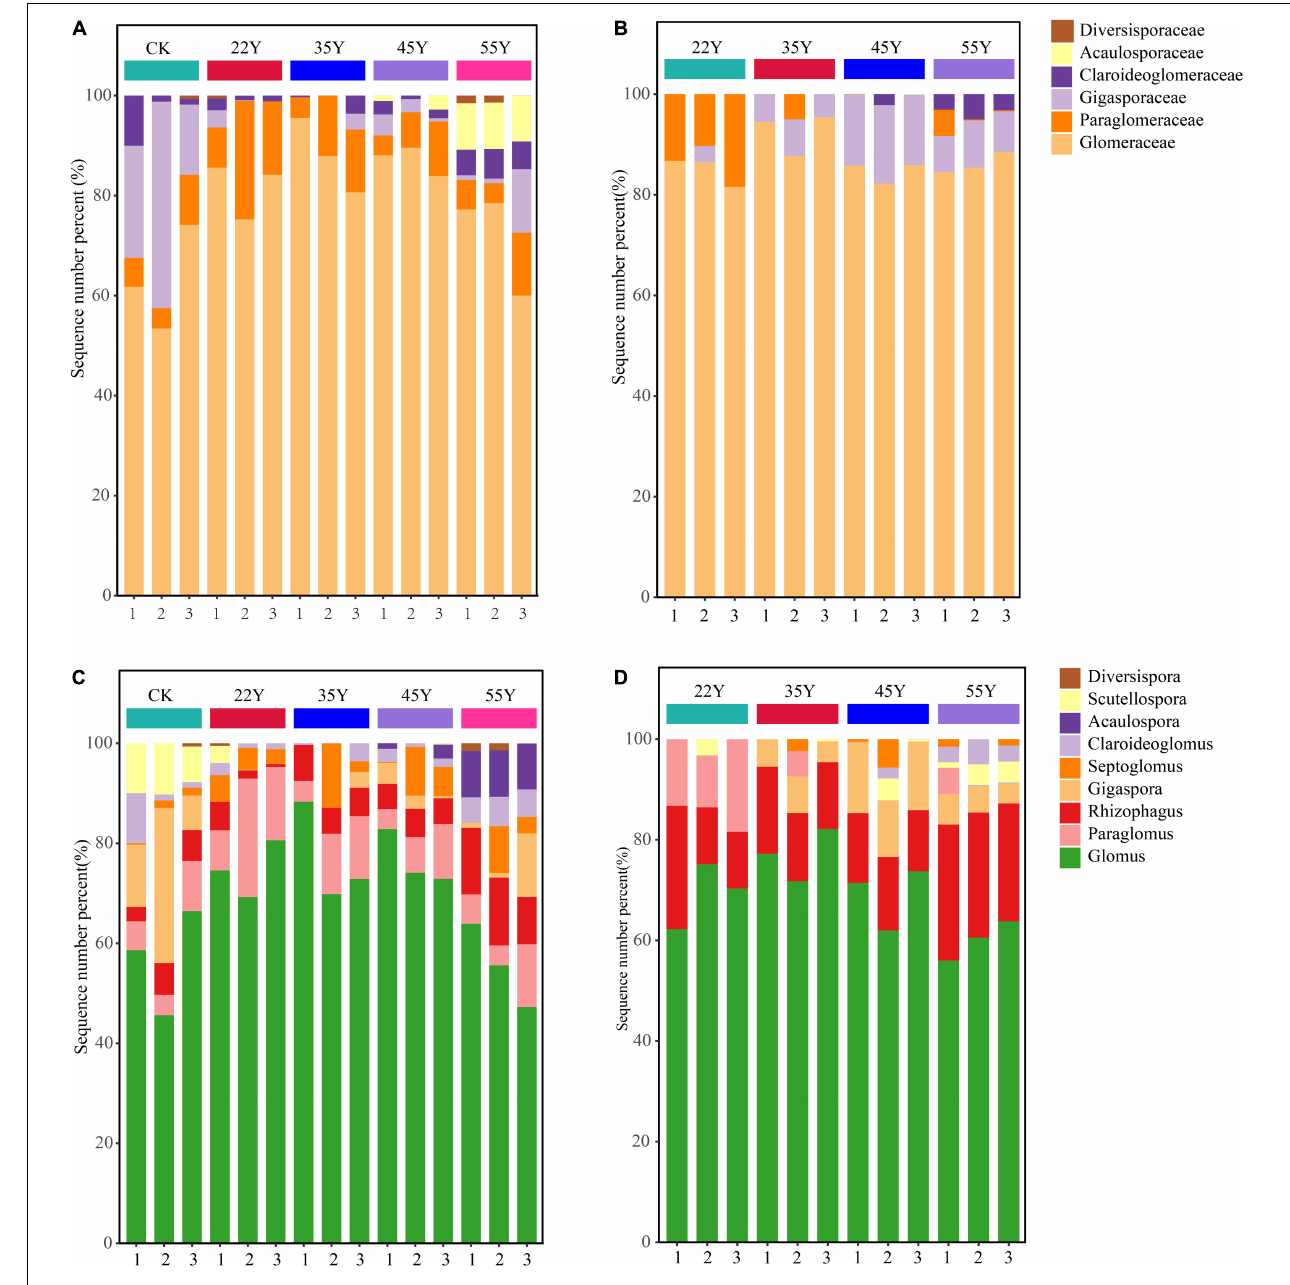
FIGURE 4 | The relative abundance of AM fungal community composition at the family (A,B) and genera (C,D) levels in the rhizosphere soils (A,C) and in the roots (B,D) along a teak plantation chronosequence. Values are mean ± standard error ( n =